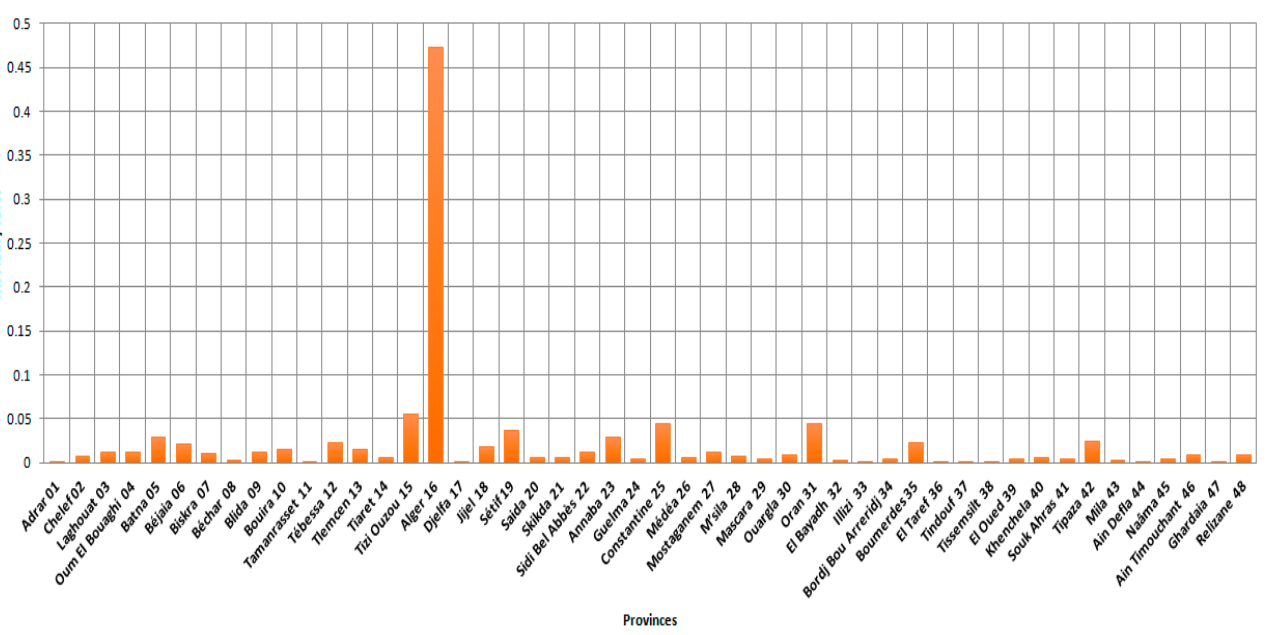
Figure 3. Provincial mortality rates (48 provinces) by COVID ‐ 19 between 1 January 2021 and 15 August 2021.